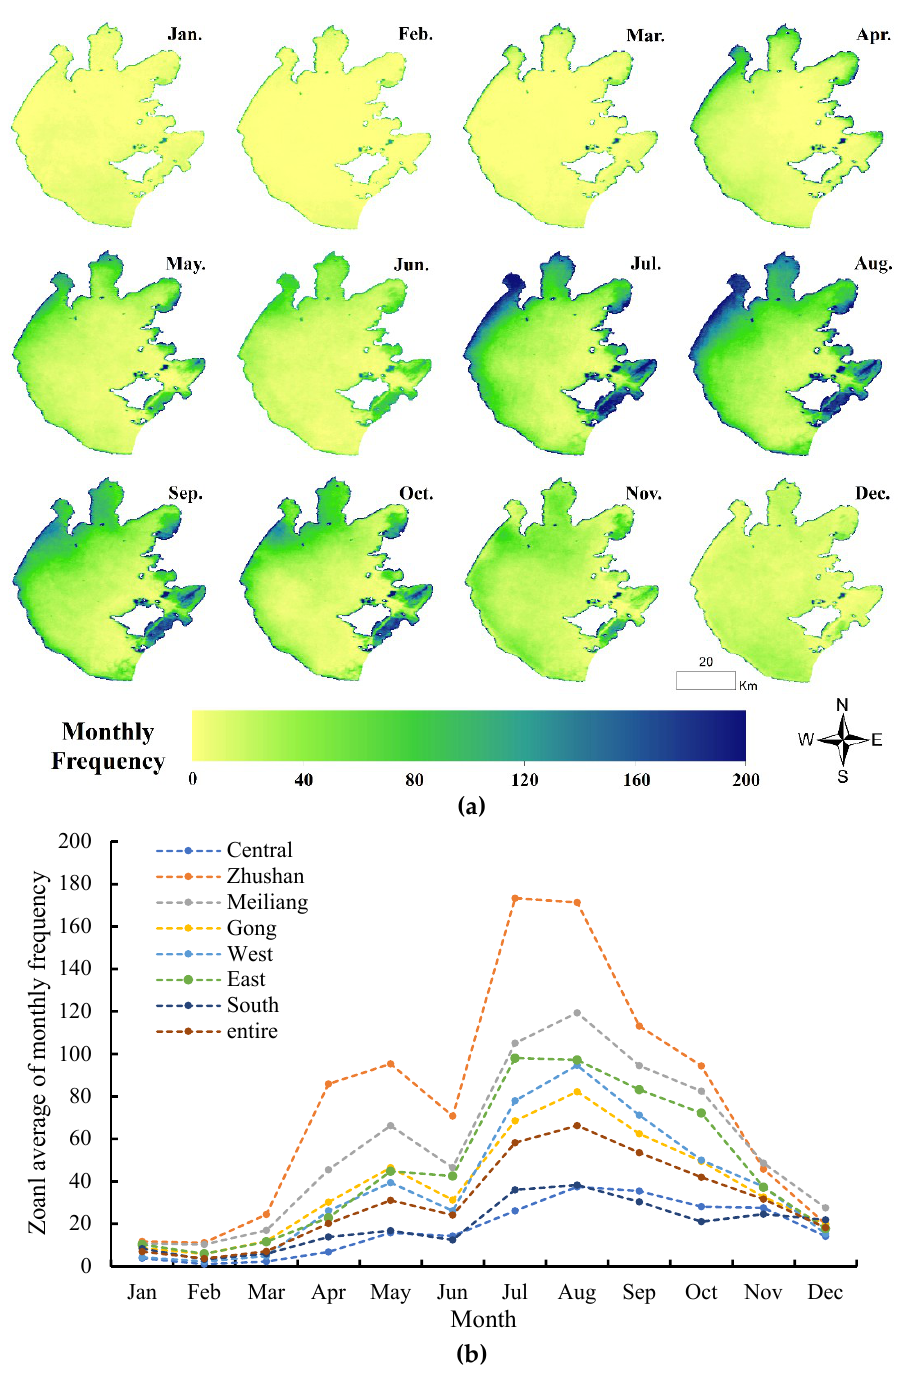
Figure 11. ( a ) Spatial accumulative monthly occurrence frequency of cyanobacteria blooms for 2000–2018; ( b ) zonal average statistics of monthly occurrence frequency.